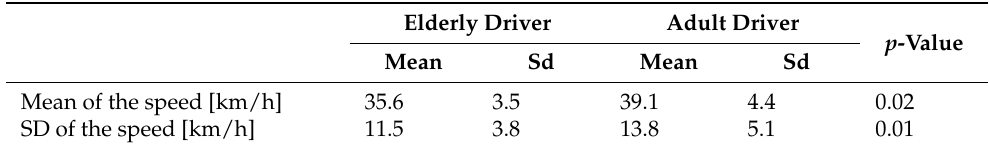
Table 7. Vehicle speed characteristics of elderly drivers and adult drivers when the subject drove